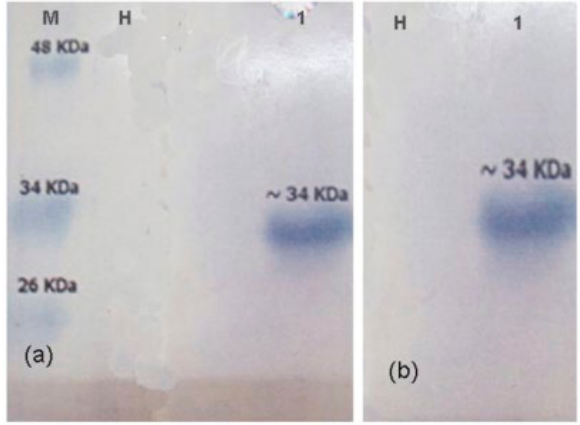
Figure 1. Western blot analysis of sorghum leaf samples suspected of MSpV infection, probed with MSpV-Flo (a) and MSpV-RU (b) antisera. Lane M, prestained protein markers (Fermentas); lane H, healthy sorghum; lane 1, sor - ghum leaf with stripe